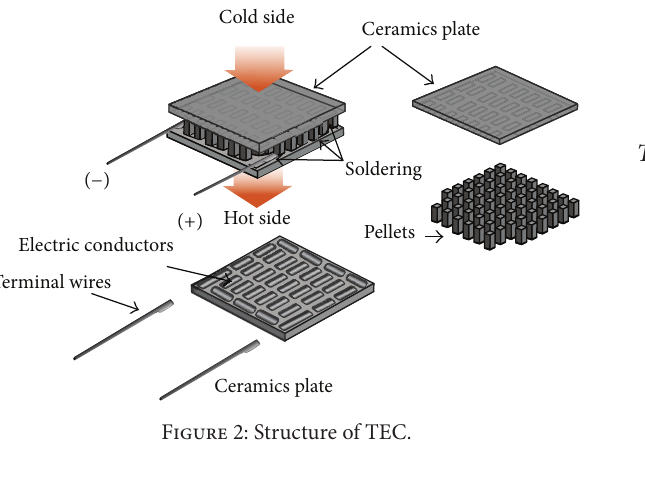
Figure 2: Structure of